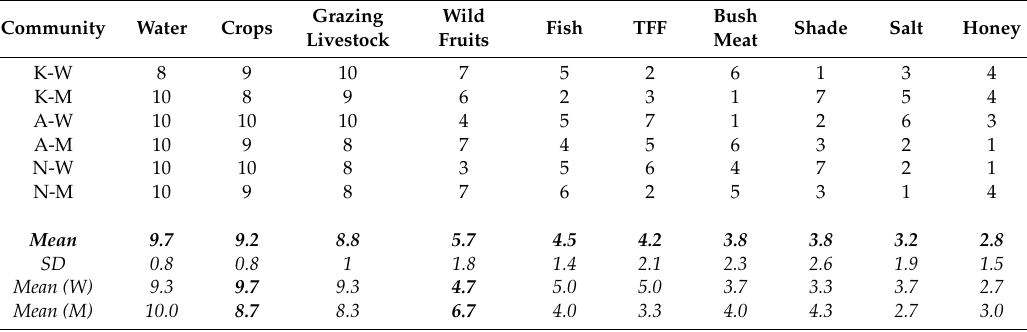
Table 1. Rankings of tiles that represented the top 10 provisioning ecosystem services (TFF = Timber, Fuel, and Fiber, K = Kopriay, A = Ayepa, N = Napasmuria, W = Women, M = Men). Tiles ranked 1st were given 10 points, through to the 10th rank given 1 point. The table is ordered according to the mean